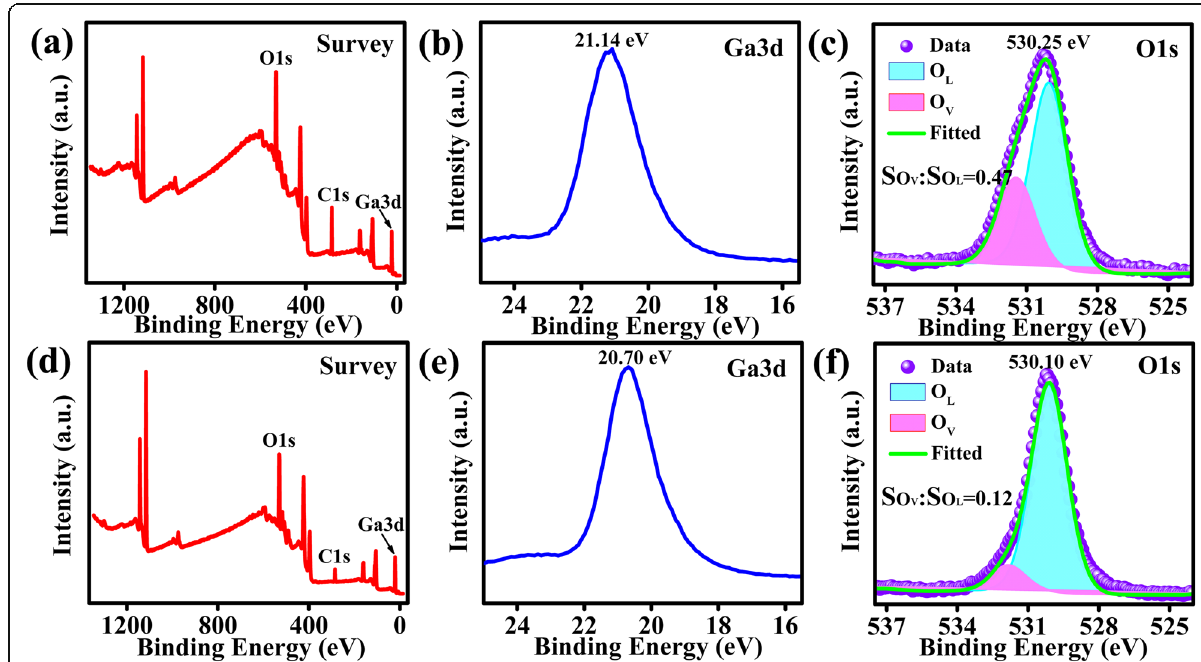
Fig. 2 XPS spectra of the β -Ga 2 O 3 film. Survey scan, Ga 3d, and O1s core level peaks acquired before annealing are shown in a – c and after annealing are shown in d – f ,